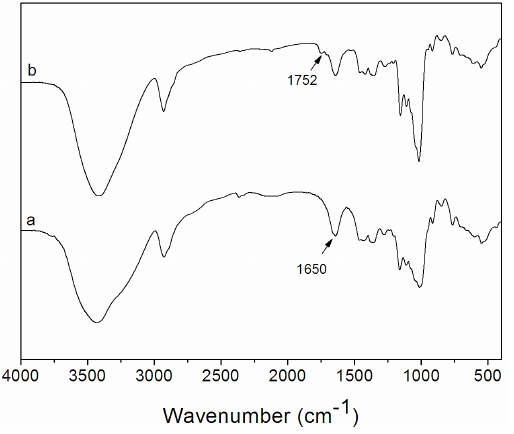
Figure 2. Fourier-transform infrared (FT-IR) spectra of ( a ) Dex and ( b ) Dex-TOS conjugate.